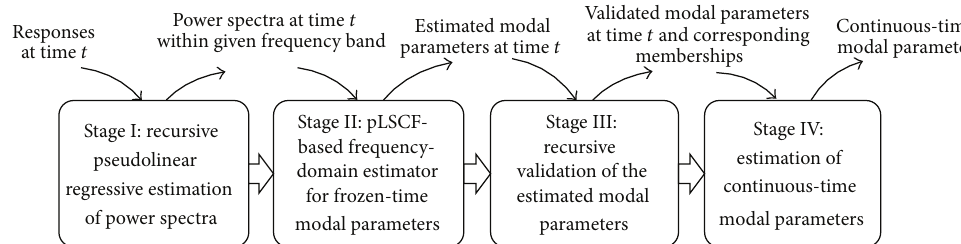
Figure 1: Conceptual procedure of the estimator.